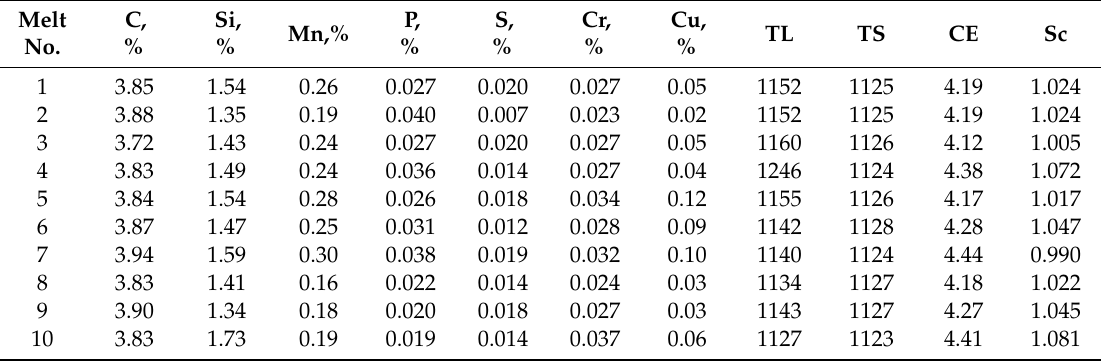
Table 2. Results of chemical and thermal analysis of the base cast